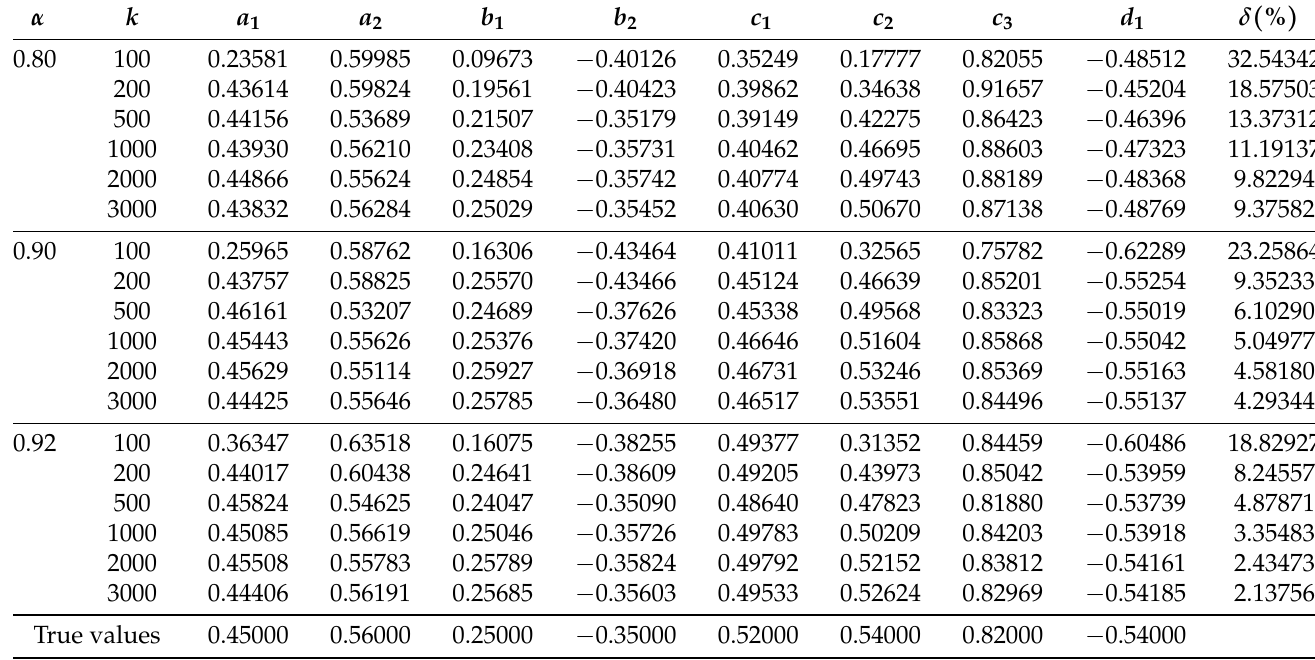
Table 3. The AM-MIFSG estimates and errors with α = 0.80, 0.90 and 0.92 ( p = 5).